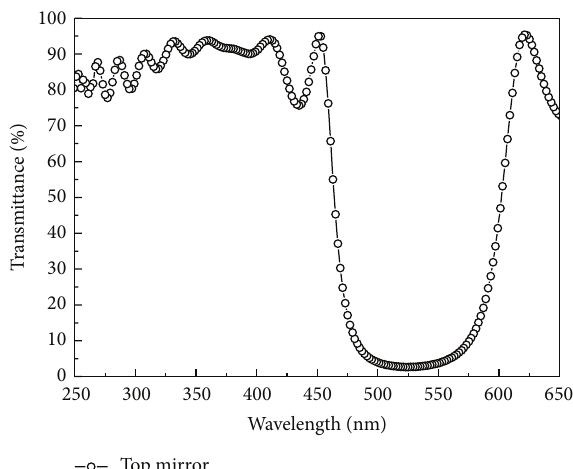
Figure 7: The transmitted spectrum of top HR mirror.